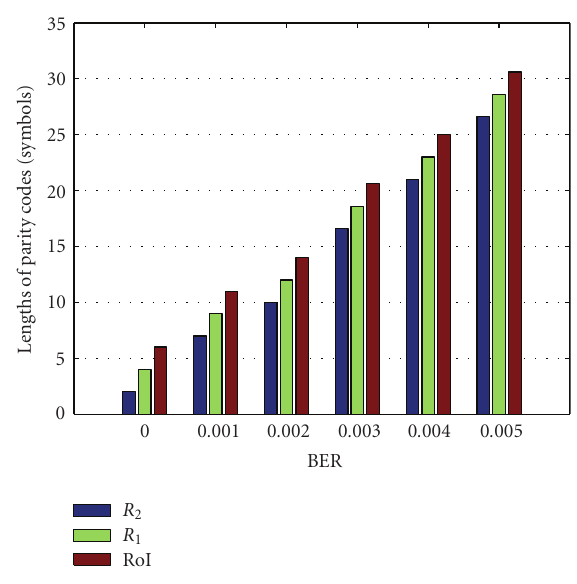
Figure 5: The ratios between the lengths of parity code C i and overall codeword of 255 symbols in di ff erent regions at various fixed noise levels.